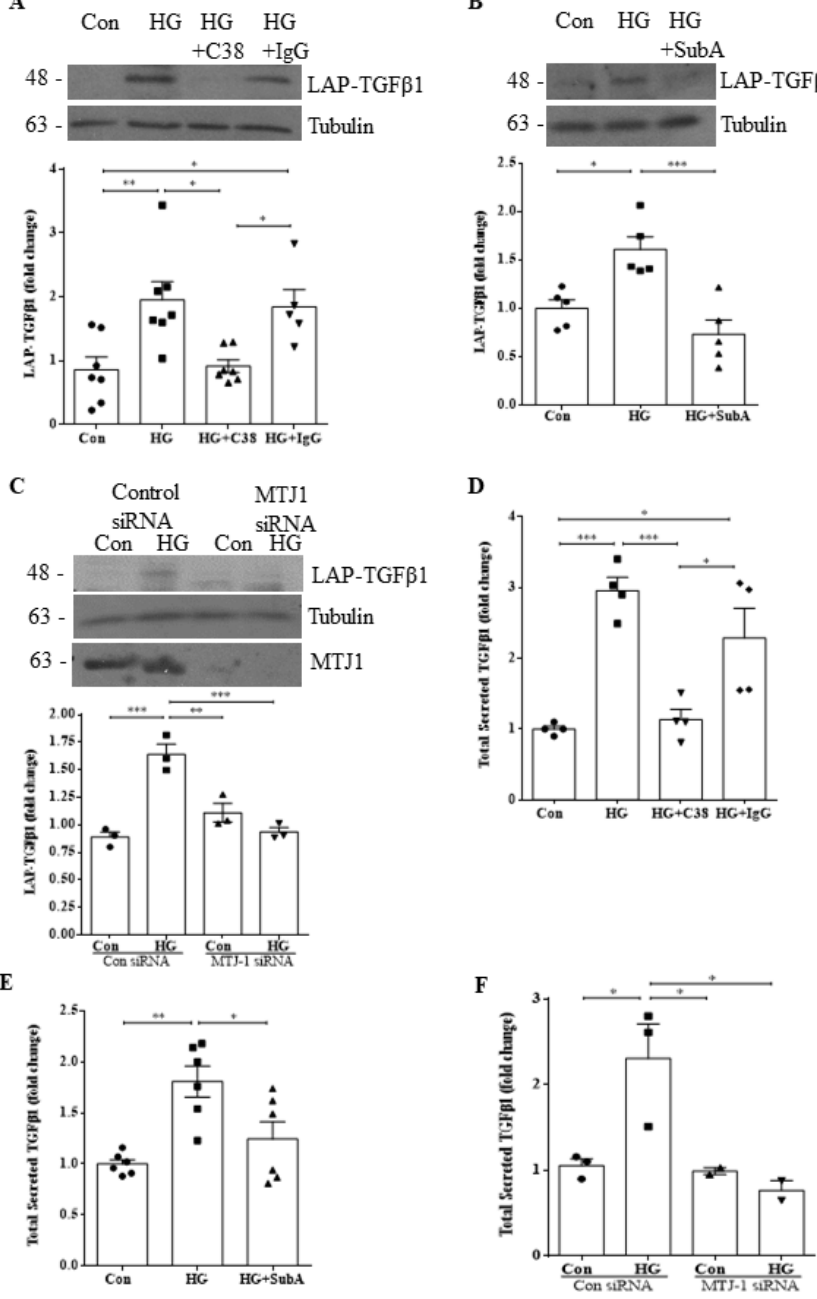
Figure 2. HG-induced TGF β 1 protein synthesis and secretion are mediated by csGRP78. Increased synthesis of LAP-TGF β 1 in response to HG (48 h) was inhibited by ( A ) the GRP78 antibody C38, but not control IgG (2 µ g, n = 6, * p < 0.05, ** p < 0.01), (B ) csGRP78 inhibitor SubA (25 ng/mL, n =